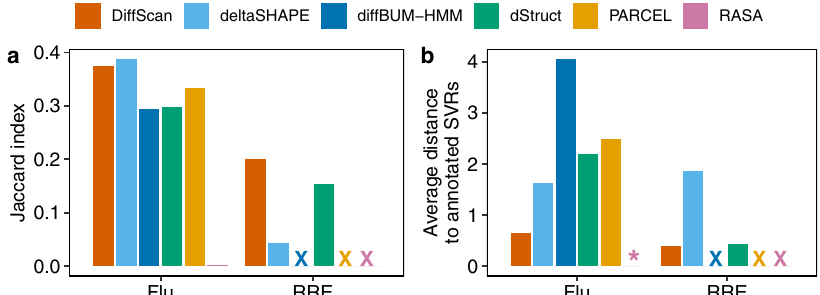
Fig. 3 Comparison of DiffScan and existing SVR detection methods with benchmark datasets. Default search length of 5 nt is used for deltaSHAPE and minimum search length of 5 nt is used for dStruct following the original article of the method. a Jaccard index between the top-20 ranked nucleotides and the annotated SVRs. b Average distance from the top-20 ranked nucleotides to annotated SVRs. “ X ” indicates that the corresponding method was not applicable for the dataset. “ * ” indicates that the average distance cannot be calculated since the corresponding method did not report any region.